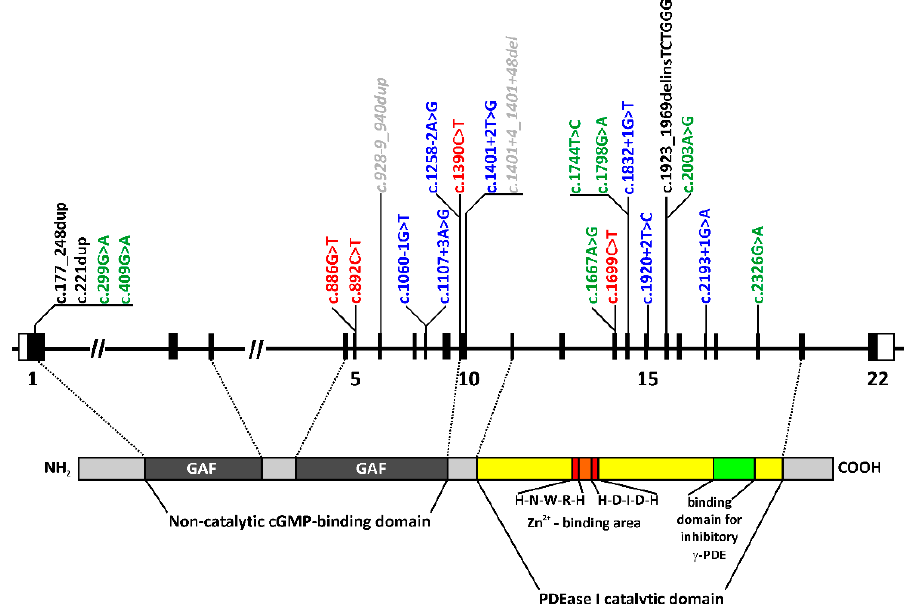
Figure 1. Genomic and protein structure of PDE6B and the locations of variants found in the patients of this study. The exon/intron organization of the PDE6B gene is shown to scale at the top, while the PDE6B polypeptide and its functional domains are shown below. The two functionally important GAF domains of the noncatalytic cyclic guanosine monophos- phate (cGMP)-binding domain are located in the amino terminal half of the protein, and the highly conserved Zn 2+ -binding motifs and the binding domain for the inhibitory γ -subunit PDE6H are located within the PDEase I catalytic domain in the carboxyterminal half of the protein. Color code of the variants: red = nonsense variants, green = missense variants, blue = splice site variants, black = insertion/deletion and duplication variants, and grey = likely benign variants.